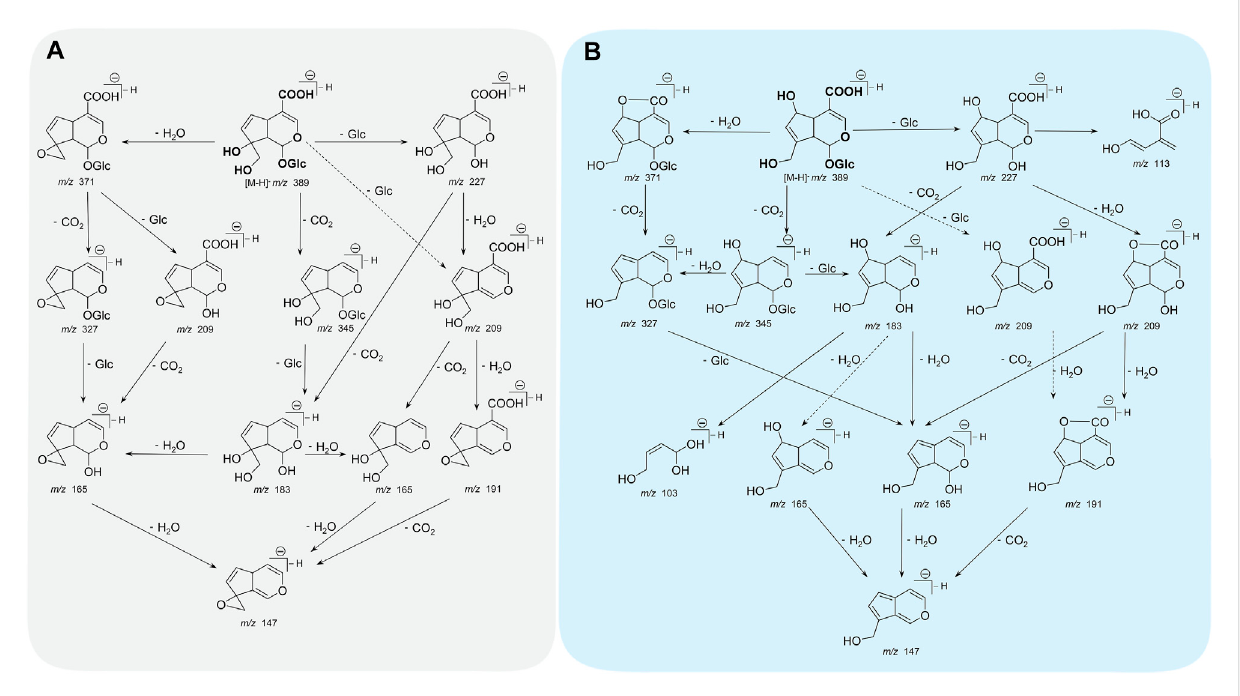
FIGURE 2 The proposed fragmentation pathway of monotropein (A) and deacetylasperulosidic acid (B) in negative ion mode of ESI-MS/MS. Solid-line arrows indicated higher probability and dotted-line arrows indicated lower probability in fragmental